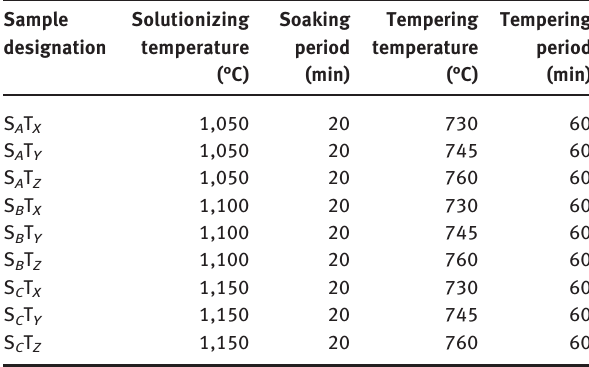
Table 2: Heat treatment performed on rolled T92 steel